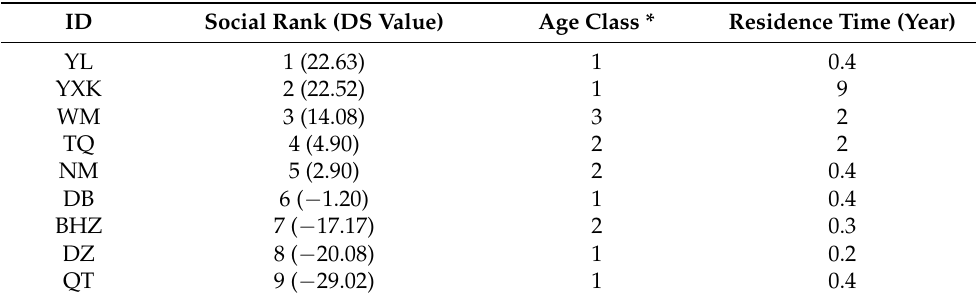
Table 2. Social ranks of adult male Tibetan